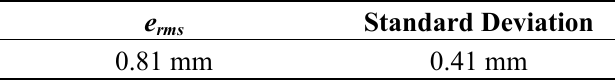
Table 2. Residual